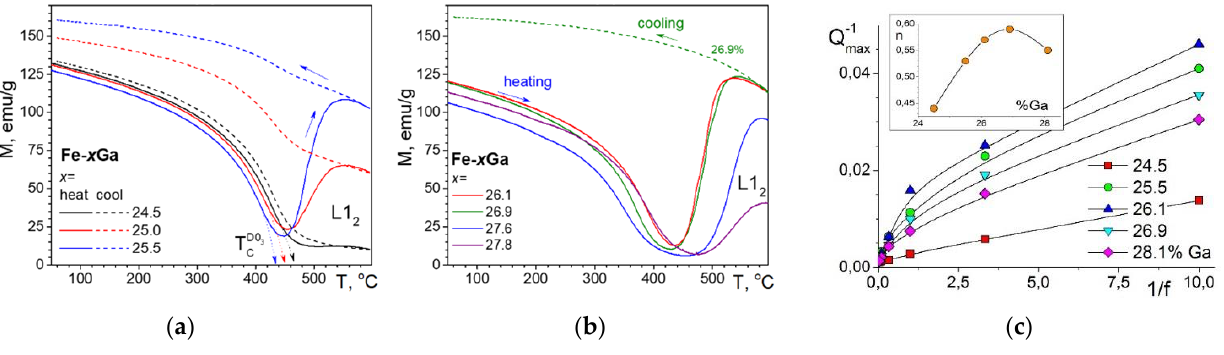
Figure 20. Temperature dependencies of magnetization through heating and cooling with ±6 °C/min rates of Fe–Ga alloys with 24.2–25.5Ga ( a ) and 25.5–28.1Ga ( b ) [60]. The transient P Tr peak height, Q max−1 , as a function of inverse frequency for forced vibrations in Fe–(24–28)Ga ( c ). Inset: values of ‘ n ’ (Q max−1 1/f n ) as a function of Ga % in the alloys [49].